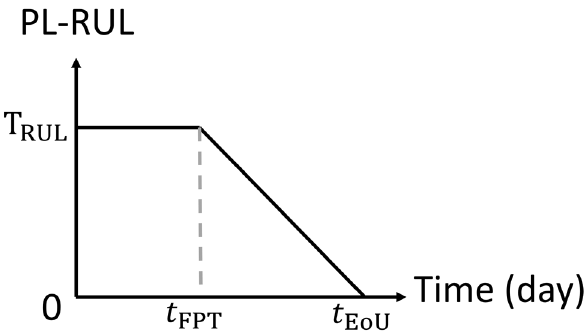
Figure 5. Piecewise linear remaining useful life diagram, where T RUL is the tuning parameter called the remaining useful life period, t FPT is the first predicting time when the first RUL predicting occurs and t EoU is the end of use time for bearing.